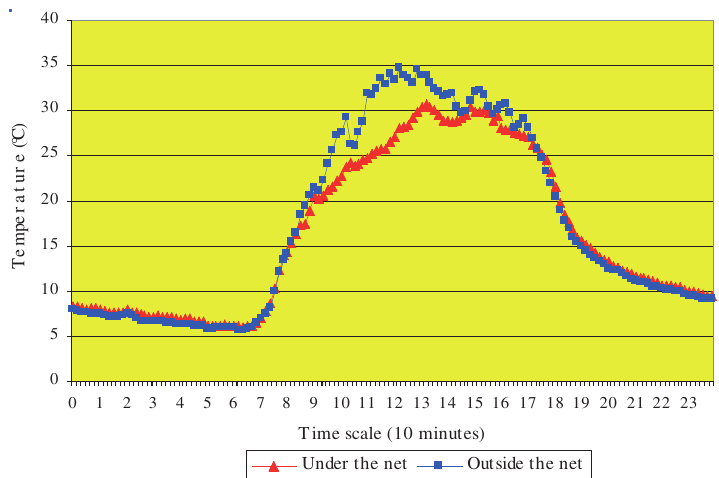
Figure 2. The mean daily course of temperature under the hail protection net and outside of it on especially hot (variable) days (T >25°C) /Pallag 2011 June 1 – September 30/ diff